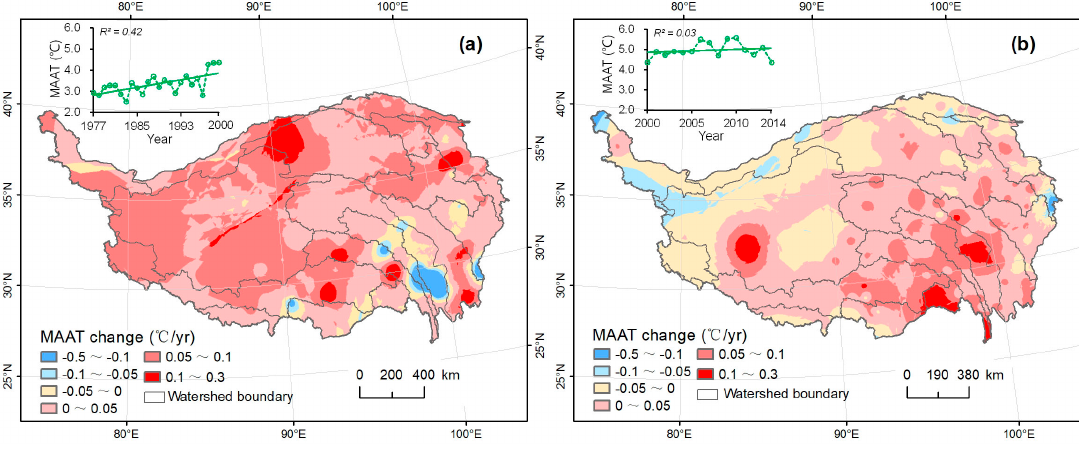
Figure 5. Variable changes in climatic factors. ( a , b ) represent annual change in MAAT and spatial patterns of annual change rate in MAAT over the TP during the periods 1977–2000 and 2000–2014, respectively; ( c , d ) represent annual changes in MAP and PET and spatial patterns of annual change rate of AI over the TP during the periods 1977–2000 and 2000–2014, respectively. Large areas of mountains on the TP were covered by glaciers (Figure 2), especially in the TR, YR, ST, NK, and QP watersheds. Previous reports have documented that glacier area on the TP has